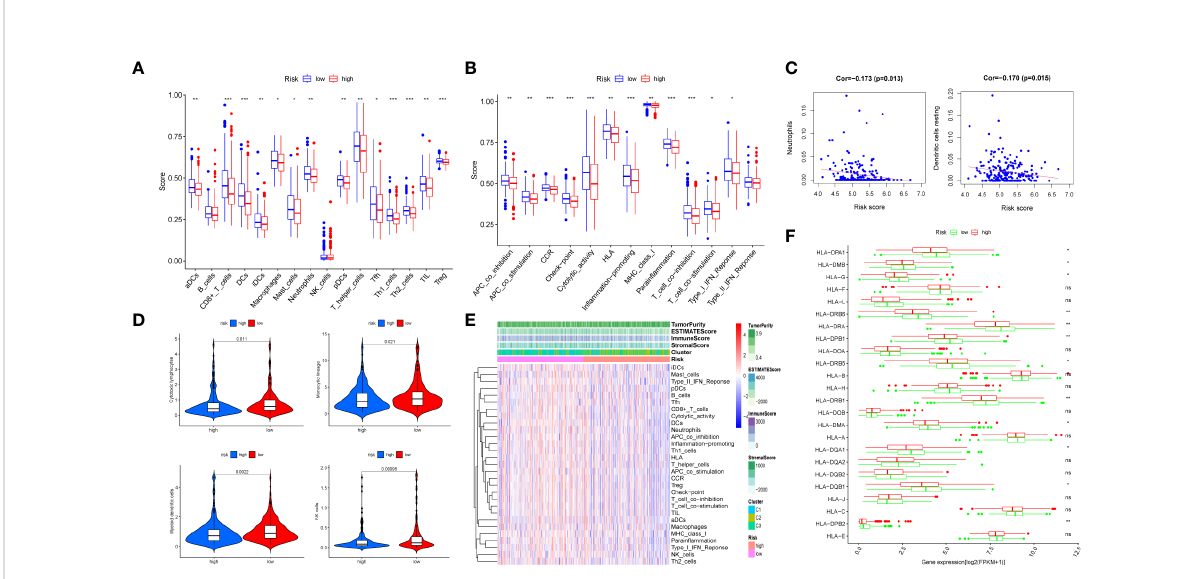
FIGURE 8 Immune in fi ltration analysis of the prognostic m7G-related lncRNA risk model. The in fi ltrating levels of 16 immune cell types (A) and 13 immune functions (B) in high-risk and low-risk groups estimated by ssGSEA. (C) The correlation of immune score and risk score calculated by CIBERSORT. (D) The violin diagram revealing the abundance of 10 types of immune and stromal cells between two groups via MCPcounter. (E) Heat map of 29 immune cells and functions displaying the difference of the immune score, stromal score, estimated score, and tumor purity in two groups through ESTIMATE. (F) Box plot of 24 MHC molecules ’ expression level in two groups. ns, not signi fi cant, *P < 0.05, **P < 0.01, and ***P <